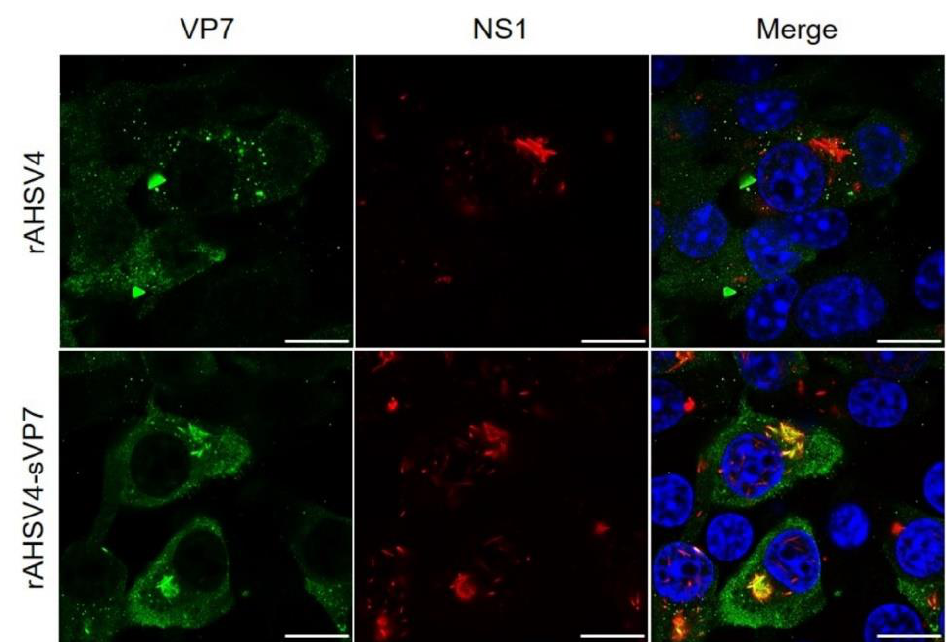
Figure 4. Intracellular distribution and colocalisation of AHSV VP7 with AHSV tubule-forming protein NS1 in wild-type rAHSV4 (top panel) and mutant rAHSV4-sVP7 (bottom panel). BSR cell monolayers, seeded on coverslips, were infected at a MOI of 0.1 of each virus, incubated for 48 h, fixed and labelled as described in Section 2.5. VP7 was labelled with anti-VP7 guinea pig primary antibody and detected using Alexa Fluor 488 anti-guinea pig secondary antibody (green). NS1 was labelled with anti-NS1 mouse primary antibody and detected using Alexa Fluor 594 anti-mouse secondary antibody (red). Nuclei were stained with DAPI (blue). Images are split into separate channels (green and red) with channels merged on the right. Areas of colocalisation are indicated by yellow in merged images. Scale bars represent 10 µ